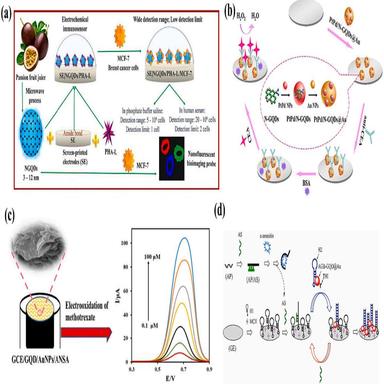
(a) Schematic depiction of the microwave-assisted synthesis of NGQDs from passion fruit juice for the quantification of MCF-7 cancer cell lines; Reproduced with permission (b) Stepwise construction of the label-free biosensor and PtPd/N-GQDs@Au, Reproduced with permission (c) Sensing probe based on GQDs and Au NPs for the quantitative measurement of methotrexate Reproduced with permission and (d) Schematics for electrode surface modification and for quantitative sen